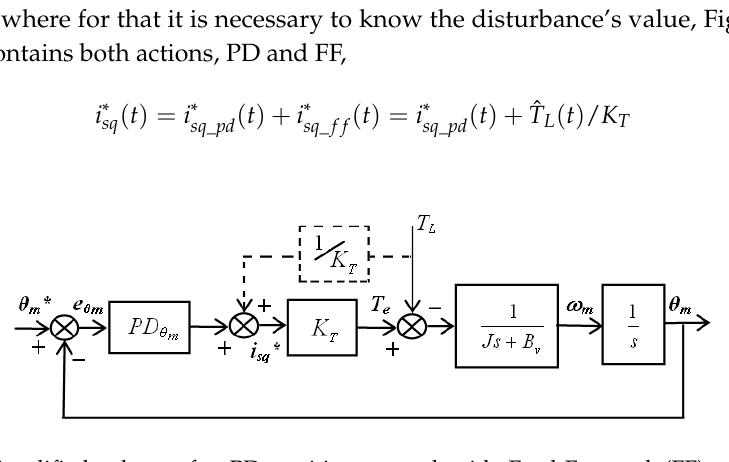
Figure 3. Simplified scheme for PD position control with Feed-Forward (FF) action for the three-phase motor.